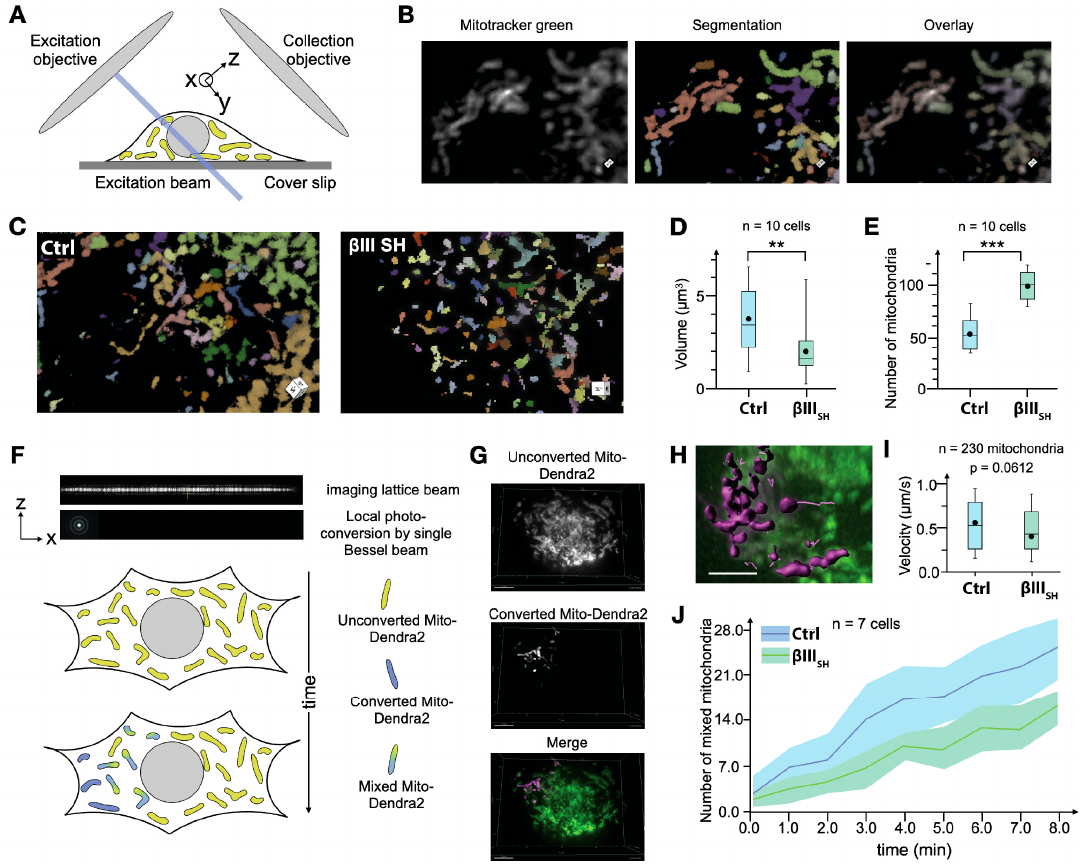
Figure 4. β III-tubulin regulates mitochondrial dynamics. ( A ) Schematic of mitochondria imaging using the lattice light-sheet microscope. The blue line represents the plane of excitation. ( B ) Representative image of MitoTracker Green intensity, segmentation and overlay. ( C ) Mitochondria in control cells have larger volume and show high-aspect ratio in comparison to cells expressing β III-tubulin targeted shRNA ( β III SH ). ( D ) Mitochondrial volumes as measured from segmentation of 3D images.** p < 0.01. ( E ) Total number of mitochondria in whole cells, *** p < 0.001. ( F ) Schematic of single Bessel beam-based photo-conversion of Mito-Dendra2 to track individual mitochondria particles and fusions. Axes shown correspond to the geometry depicted in ( A ). ( G ) A representative image of a cell showing mito-Dendra2 post-photoconversion. ( H ) Segmentation and tracking of mitochondria in the converted channel enable quantitation of mitochondrial fusion. ( I ) Mitochondrial speed in control cells and in cells expressing β III-tubulin targeted shRNA ( β III SH ), p = 0.0612 ( J ) Quantitation of double-colored mitochondria as a readout of mitochondrial fusion and mixing, n = 3 independent experiments. Ctrl = Control cells; β III SH = cells expressing β III-tubulin targeted shRNA.